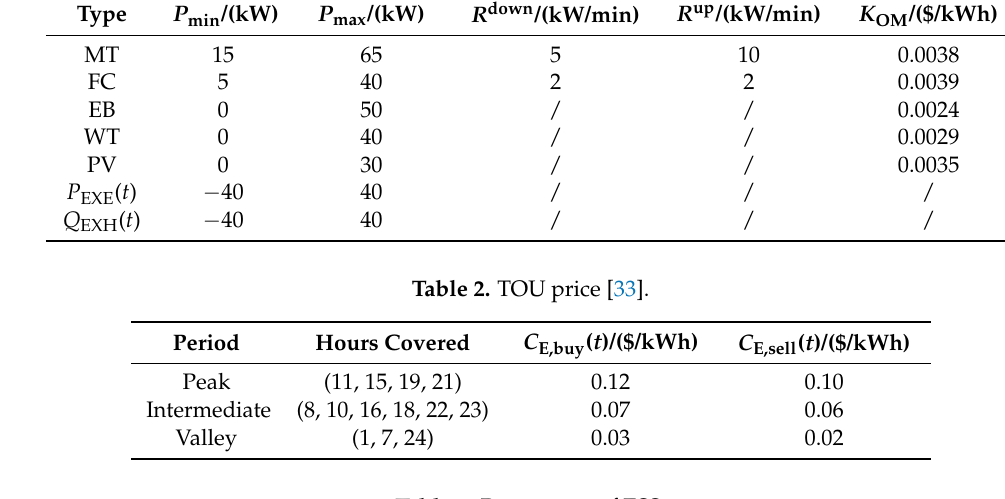
Table 3. Parameters of ESS.